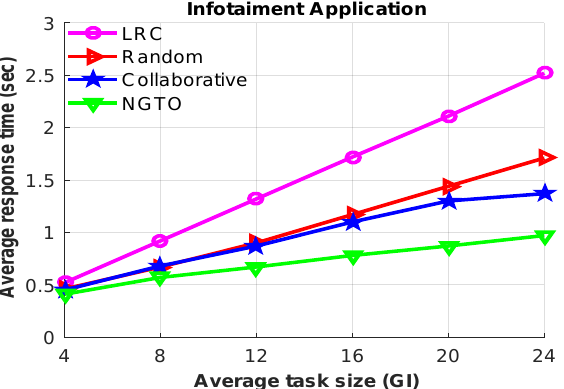
Figure 8. The average response times for different task sizes of infotainment applications.